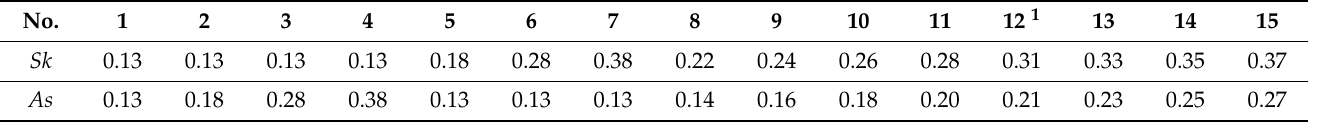
Table 3. facSk and facAs lists during XBeach modeling: No. (simulation number), Sk ( facSk ), and As ( facAs ).